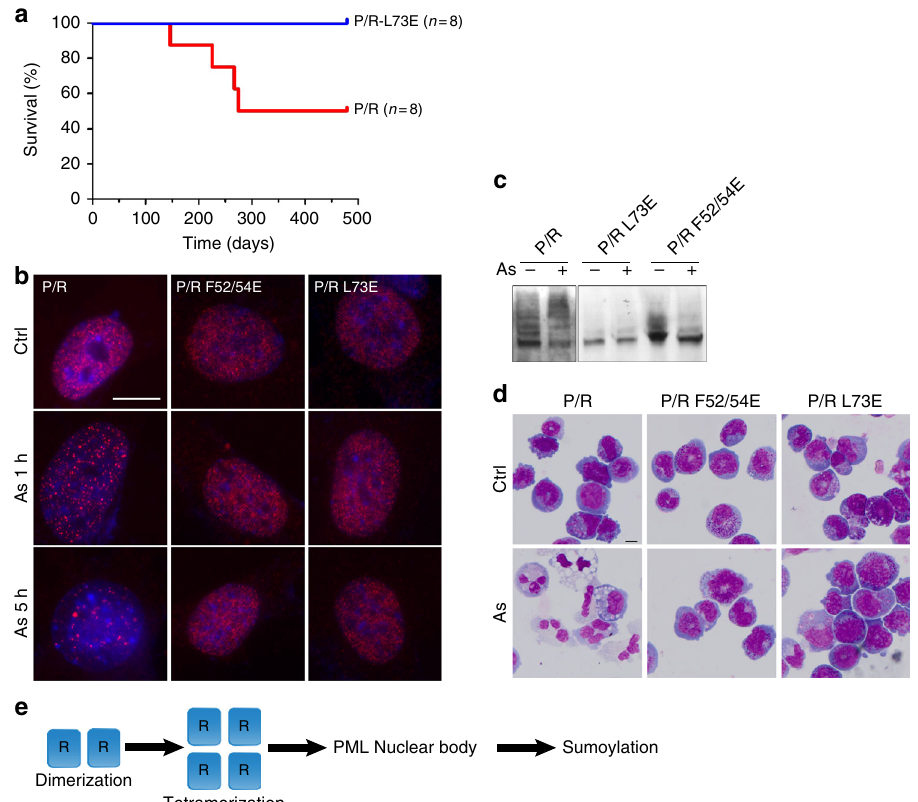
Fig. 6 PML RING tetramerization is important for APL development and arsenic targeting of PML/RARA-transformed cells. a Survival data of MRP8-PML/ RARA or -PML/RARA L73E transgenic mice 42 . b Pml − / − MEFs expressing HA-PML/RARA, HA-PML/RARA F52/54E or HA-PML/RARA L73E were treated with As 2 O 3 (10 – 6 M) prior to immuno fl uorescence analysis. Scale bar is 5 μ m. c Sumoylation of HA-PML/RARA after 1 h of As 2 O 3 exposure was monitored